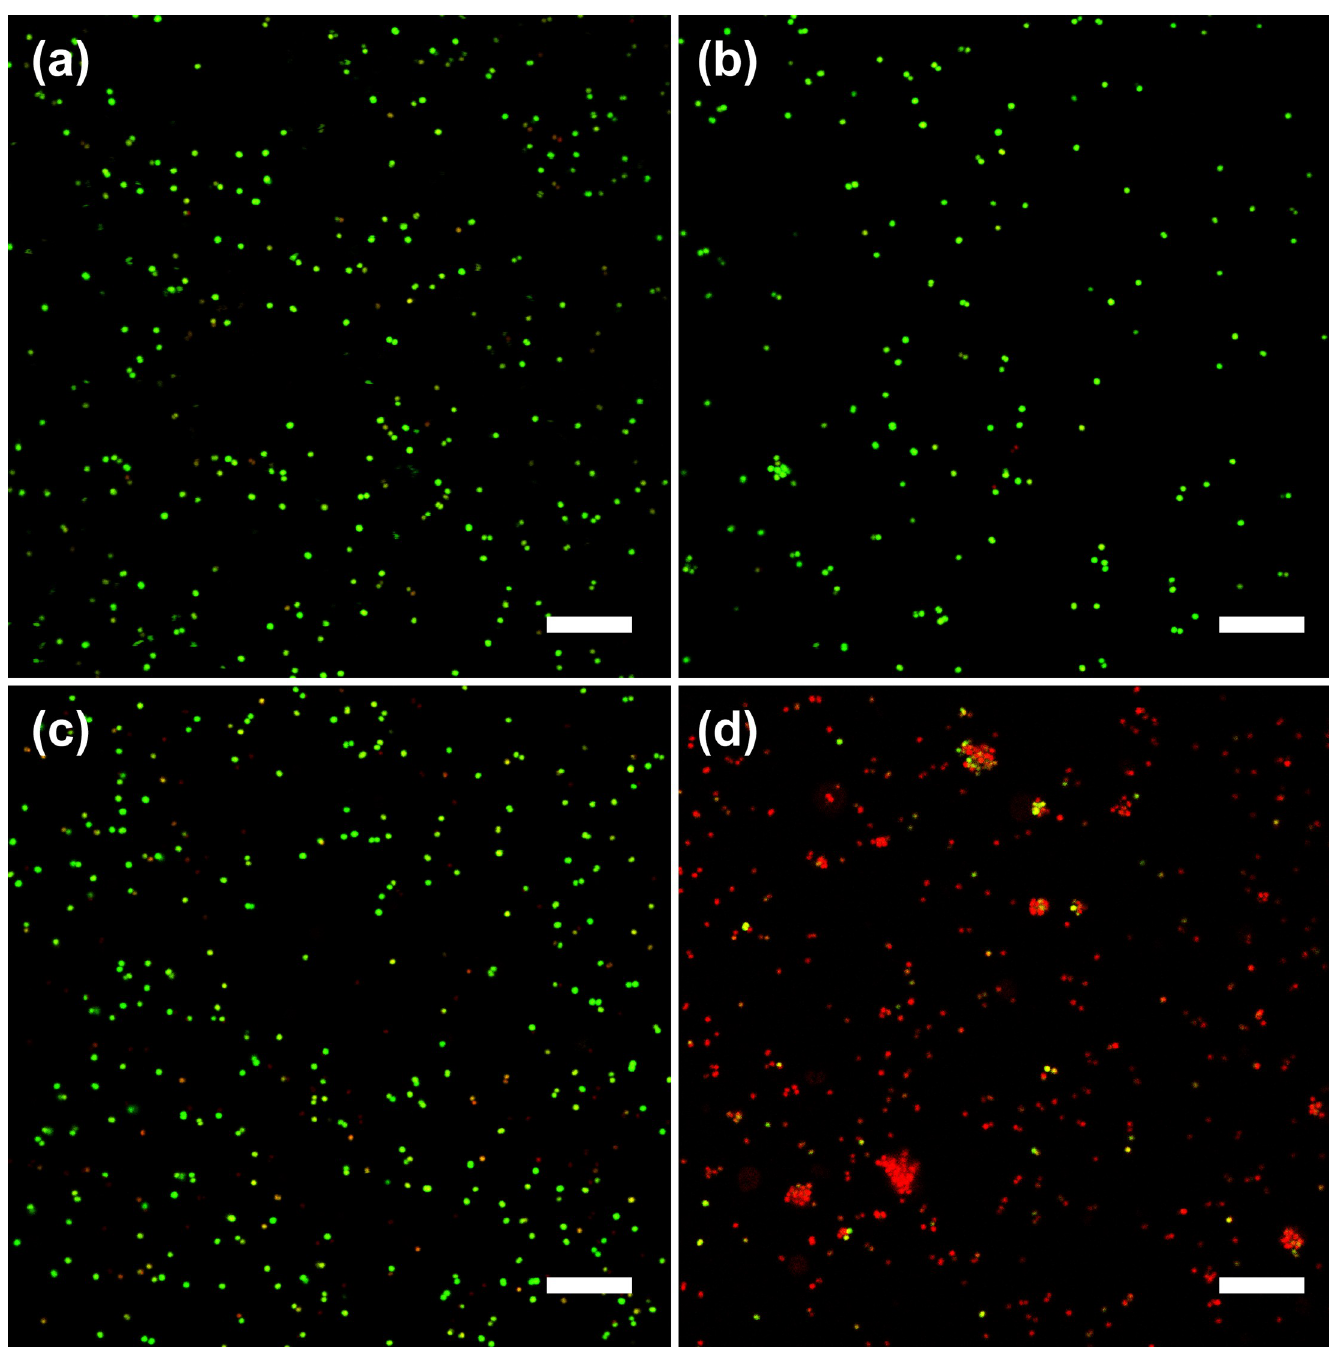
Fig 6. Merged fluorescence micrographs of MRSA cells stained by propidium iodide/SYTO 9 after different COE treatments in PBS for 2 hours. (a) Non-treated, (b) 8 μ M COE-S6 treated, (c) 8 μ M COE-D8 treated, (d) both 8 μ M COE-D8 and 8 μ M COE-S6 treated. Scale bars are 20 μ m. The propidium iodide fluorescent channel (presented in red color) was observed by excitation at 570 nm and the emission was collected in the range of 600 − 630 nm. The SYTO 9 fluorescent channel (presented in green color) was observed by excitation at 488 nm and the emission was collected in the range of 500 − 530 nm.